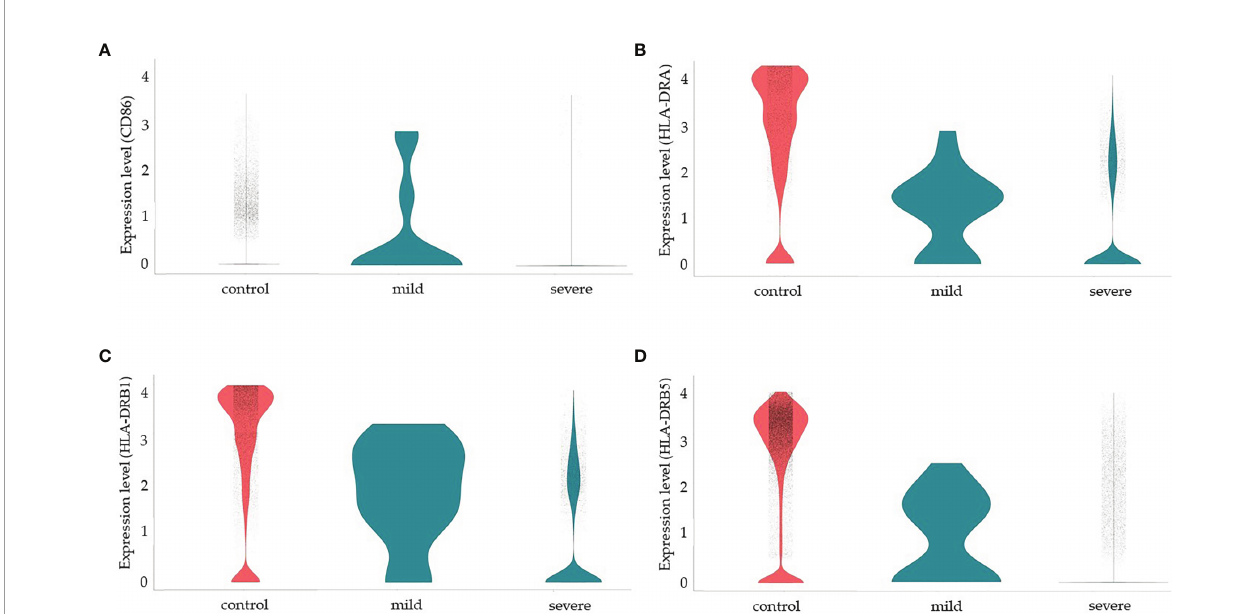
FIGURE 5 | Modulation of co-stimulatory and HLA molecules in MSCs from COVID-19 patients. We made a non-comparative analysis of MSCs from control uninfected individuals and patients with mild or severe COVID-19, as indicated. The molecules analyzed were CD86 (A) , HLA-DRA (B) , HLA-DRB1) (C) , and HLA- DRB5 (D)